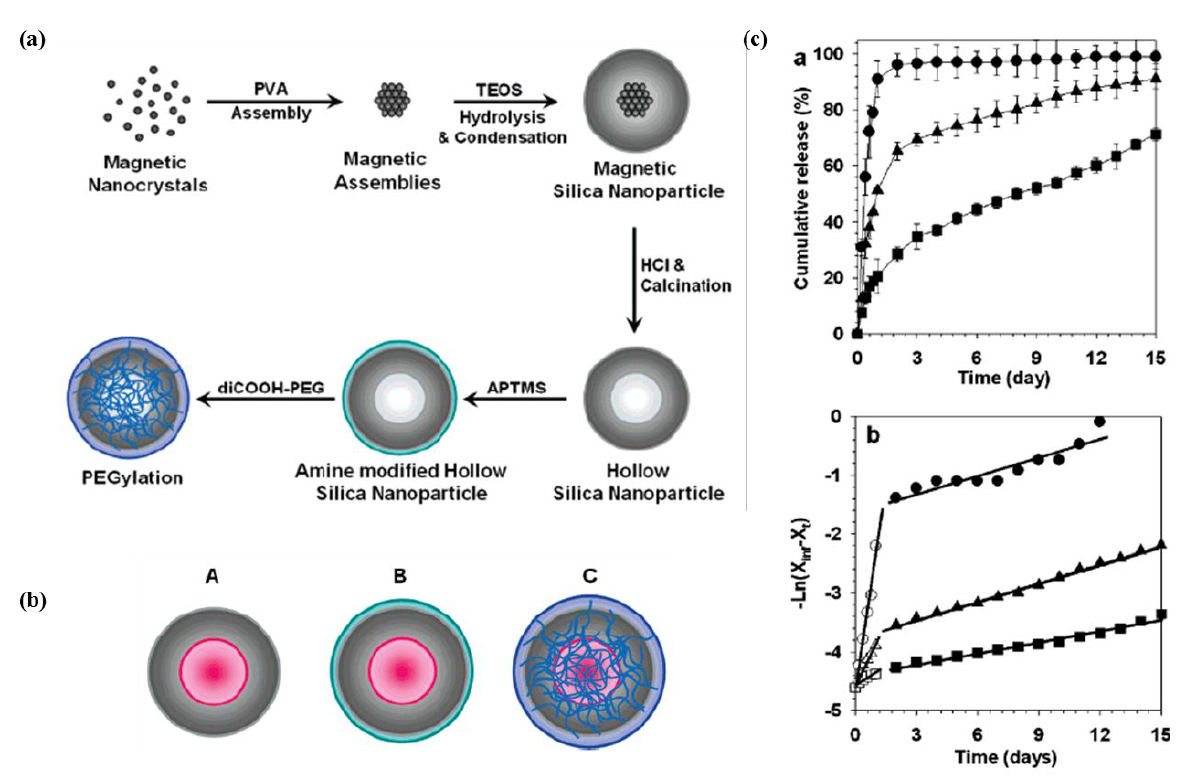
Figure 4. ( a ) Schematic illustration of drug-loaded hollow silica nanoparticles for drug delivery vehicles; ( b ) three types of hollow silica nanoparticles (HSNPs) as drug delivery vehicles: ( A ) HSNPs-OH, ( B ) HSNPs-NH and ( C ) HSNPs-PEG; ( c ) DOX release profiles 2 and semilogarithmic plot of DOX release of HSNPs (●), HSNPs-NH2 (▲) and HSNPs-PEG (■). Reproduced from [52] with permission of [American Chemical Society